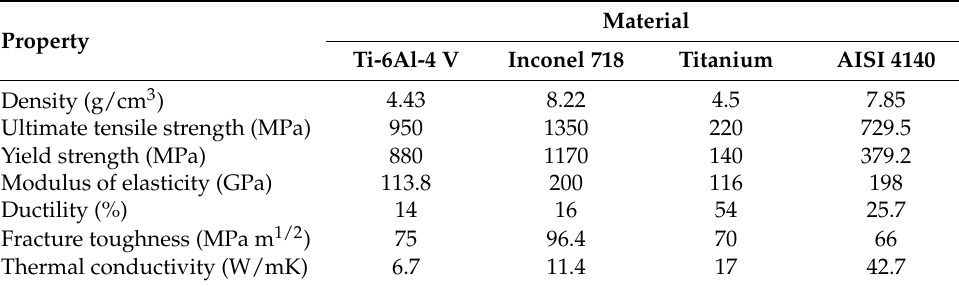
Table 1. Properties of some super-alloys at room temperature